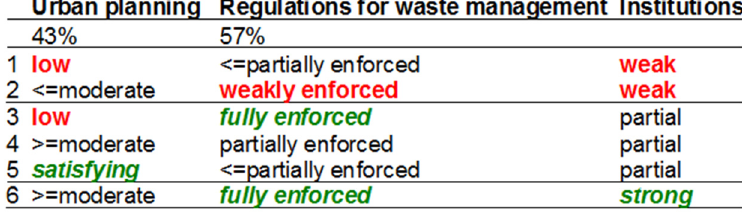
Figure A6. Utility function of the aggregated attribute Institutions.